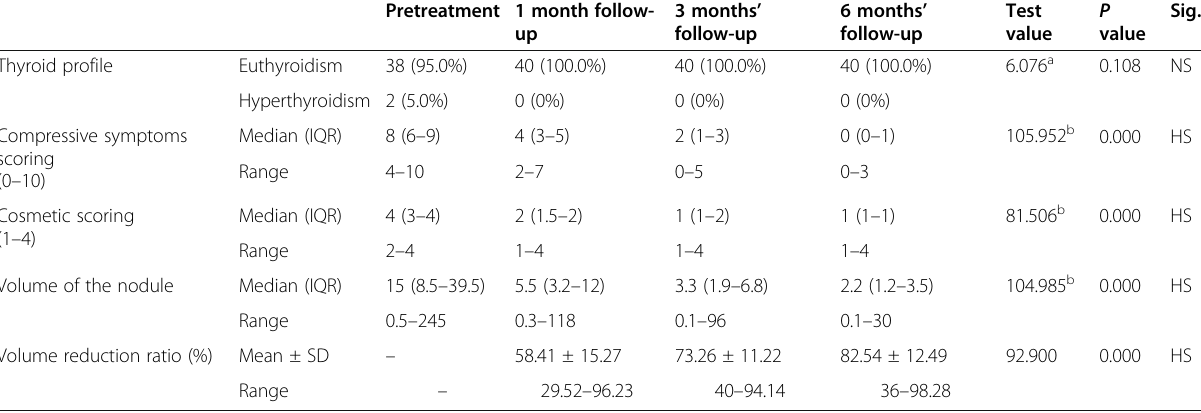
Table 3 Summary of the follow-up of the thyroid nodule volume, patients ’ symptoms, and the thyroid hormone level Pretreatment 1 month follow- up